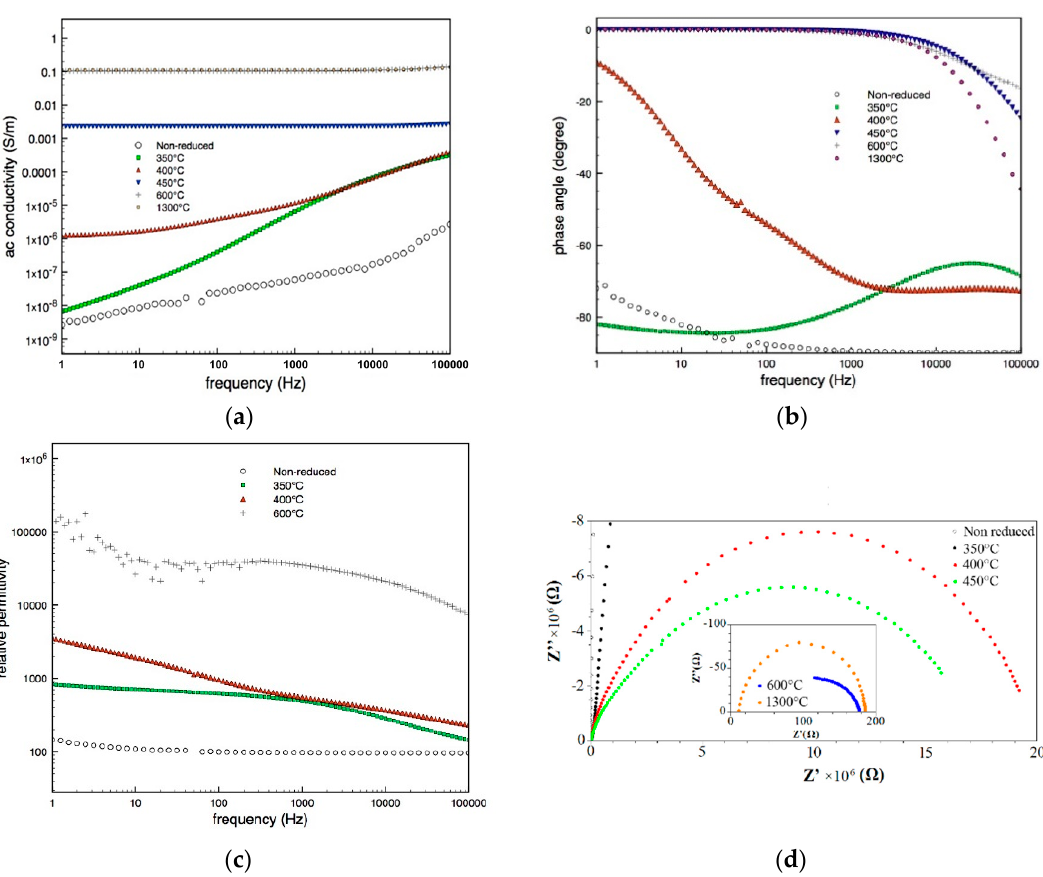
Figure 6. ( a ) AC conductivity ( b ) phase angle ( c ) permittivity, ( d ) complex plane plot of real impedance